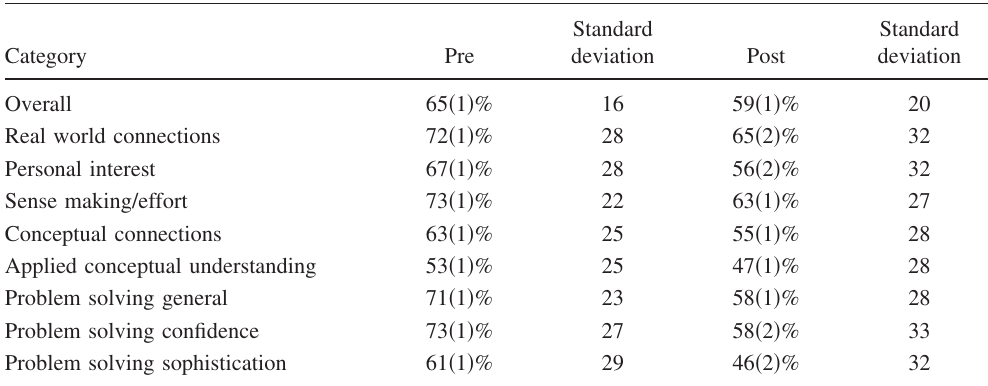
TABLE I. Typical CLASS percent favorable results. The percentage of favorable responses (cid:1) students agreeing with experts (cid:2) , pre- and postsemester, given by N =397 students, taking a reform-oriented course that led to a 0.58 normalized gain on the Force and Motion Conceptual Evaluation (cid:1) Ref. 20 (cid:2) . See the Appendix for category details. Standard errors are in